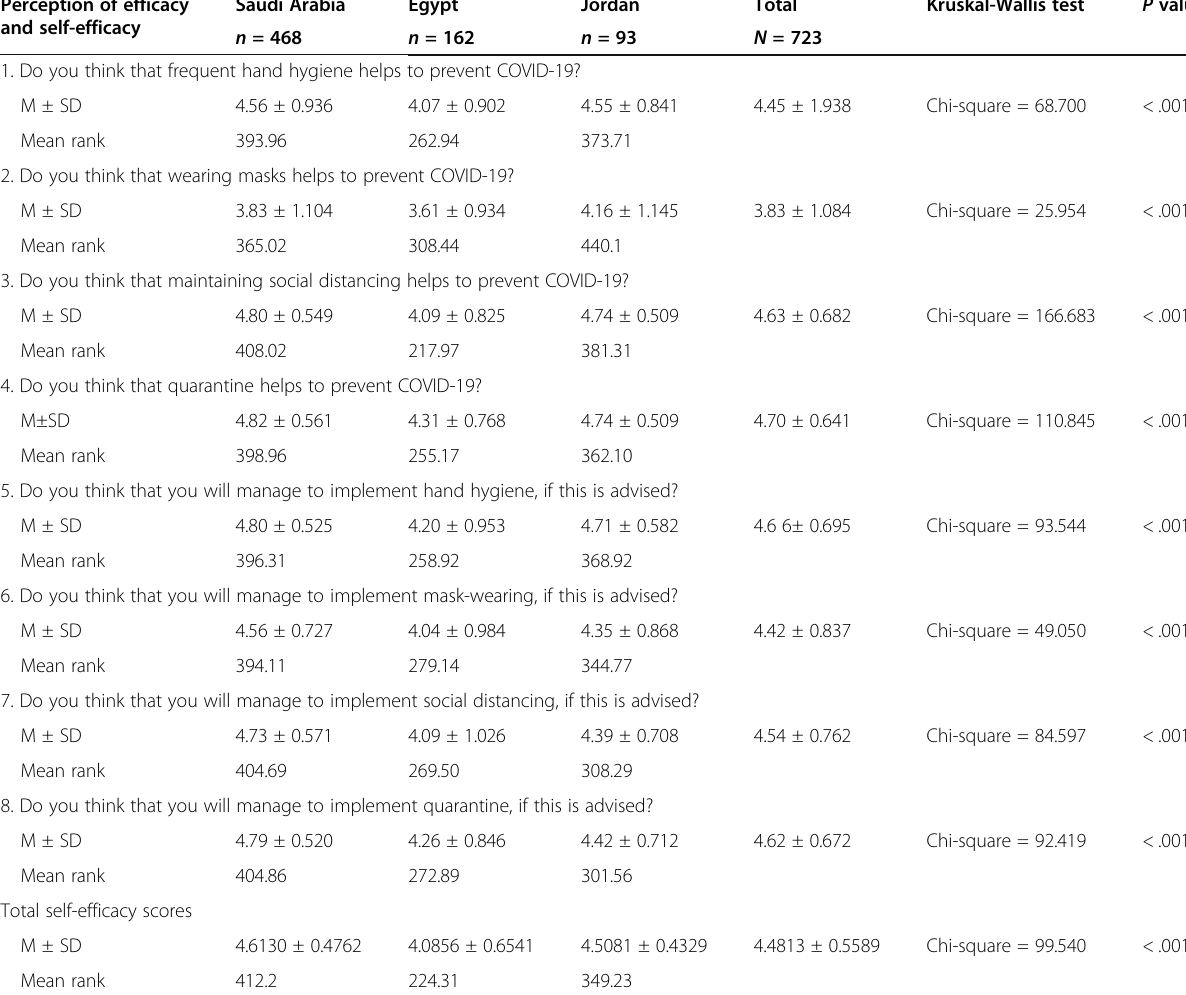
Table 8 Differences in mean “ perception of efficacy and self-efficacy ” scores, according to country of origin Perception of efficacy and